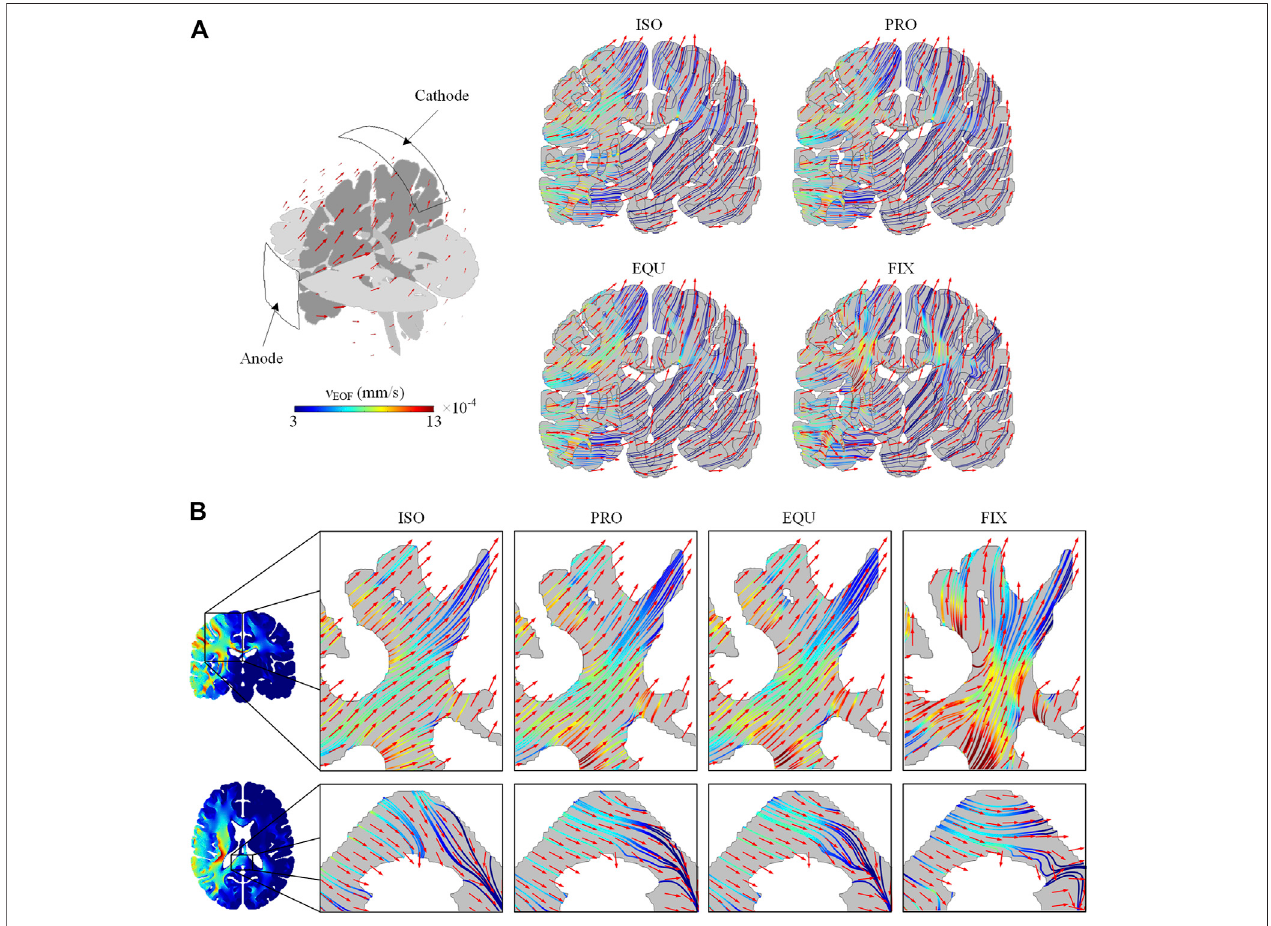
FIGURE6|(A) Thepathwaysand directionofEOF acrossthe brainin ISO, PRO,EQU, and FIX models onacoronal plane. (B) The pathways and direction ofEOF in corona radiata onacoronal plane and thesplenium ofthecorpuscallosum on an axialplane. The colorofEOF pathways denotes the EOF magnitude. The red arrows indicate the direction of induced